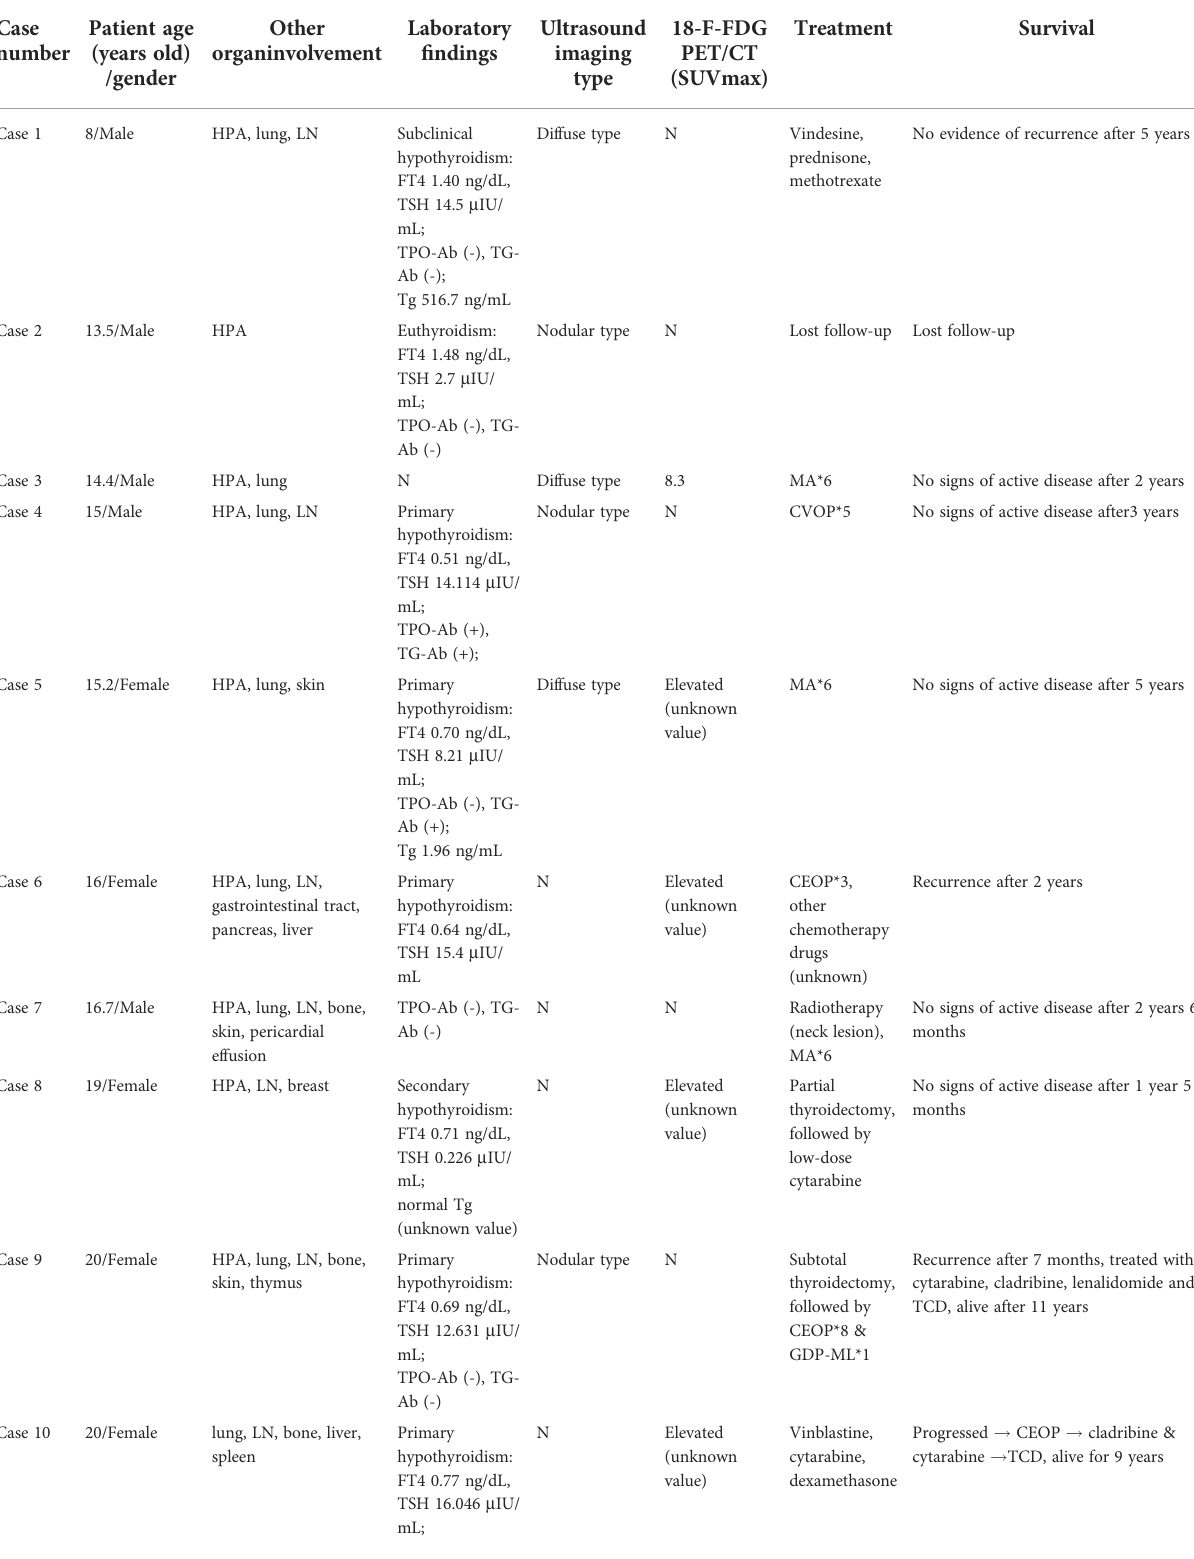
TABLE 1 The characteristics, treatment, and prognosis of patients with thyroid